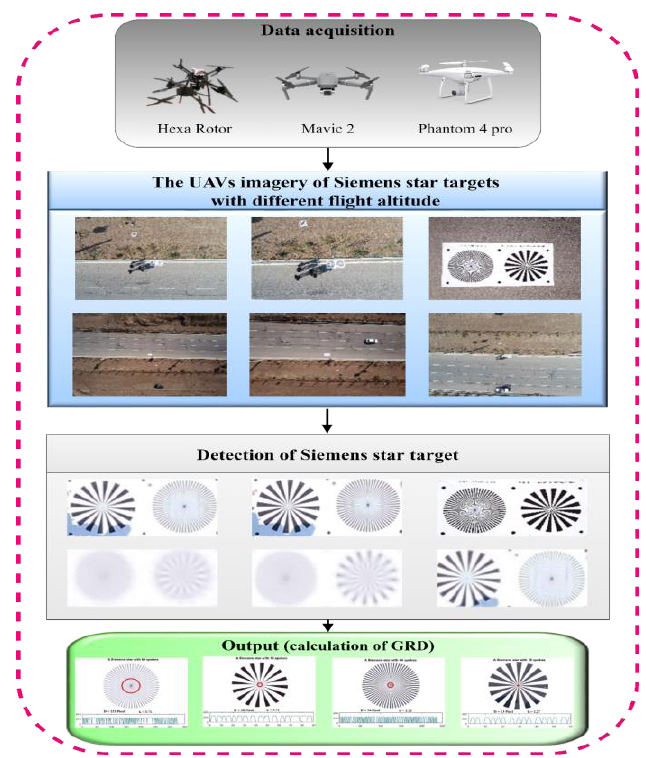
Figure 4. Flowchart of the proposed spatial resolution determination